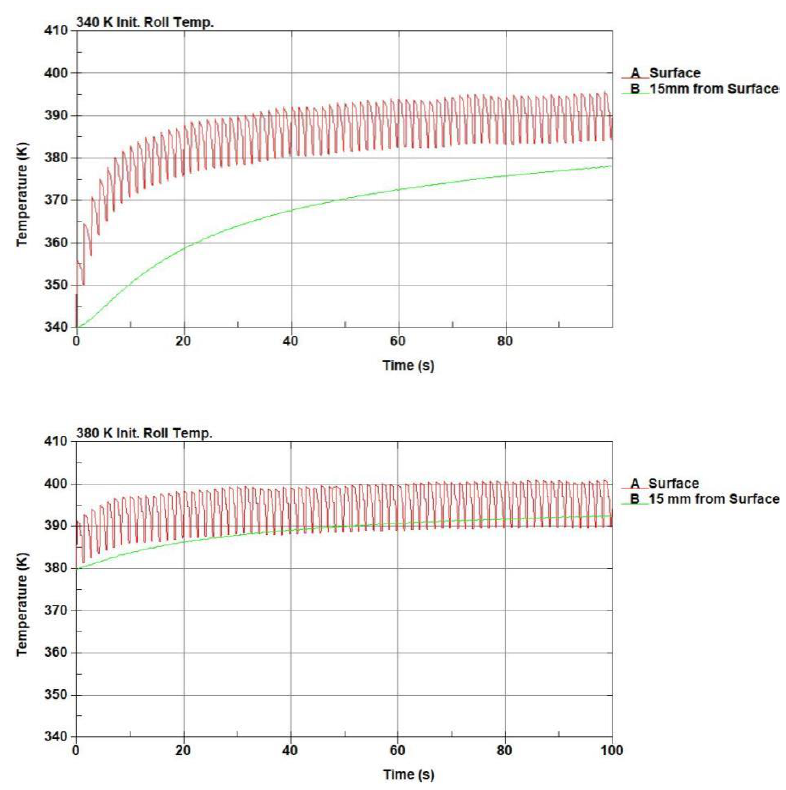
Figure 10. Comparison of temperature evolution between rolls with 340 Κ ( up ) and 380 Κ ( down ) initial temperature.